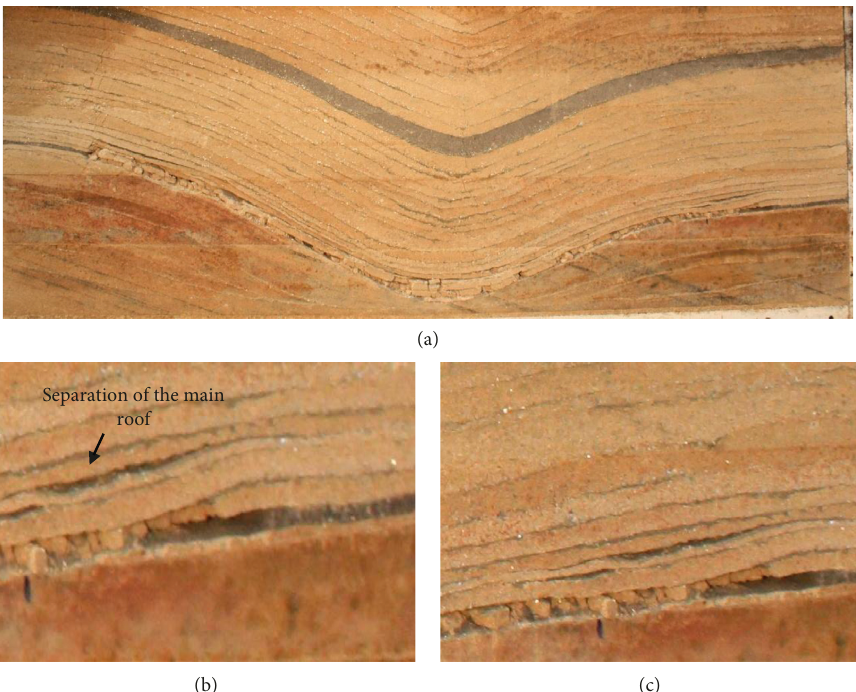
Figure 11: Activity characteristics of the overlying strata at the end of mining. (a) The whole picture of the mode after mining. (b) Separation of the main roof. (c) Separation of overlying strata.